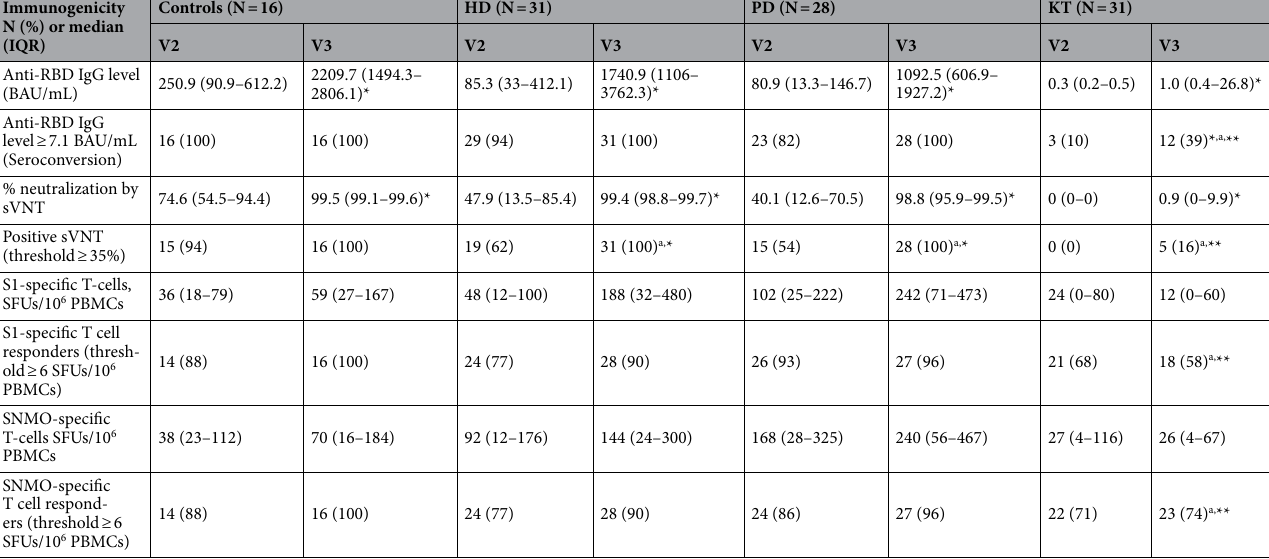
Table 2. SARS-CoV-2-specific humoral and cellular immune responses in KT, PD, and HD patients and healthy controls vaccinated with 2 doses of inactivated SARS-CoV-2 vaccine (V2) followed by a third dose